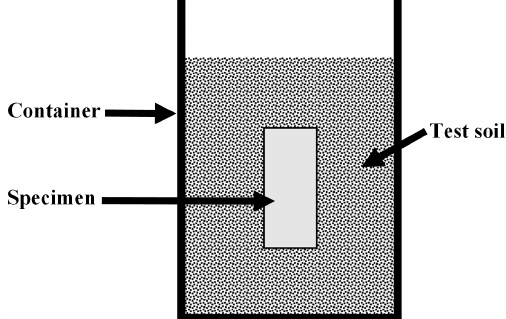
Figure 1. Experimental setup scheme during the exposure of metal coupons, according to ASTM